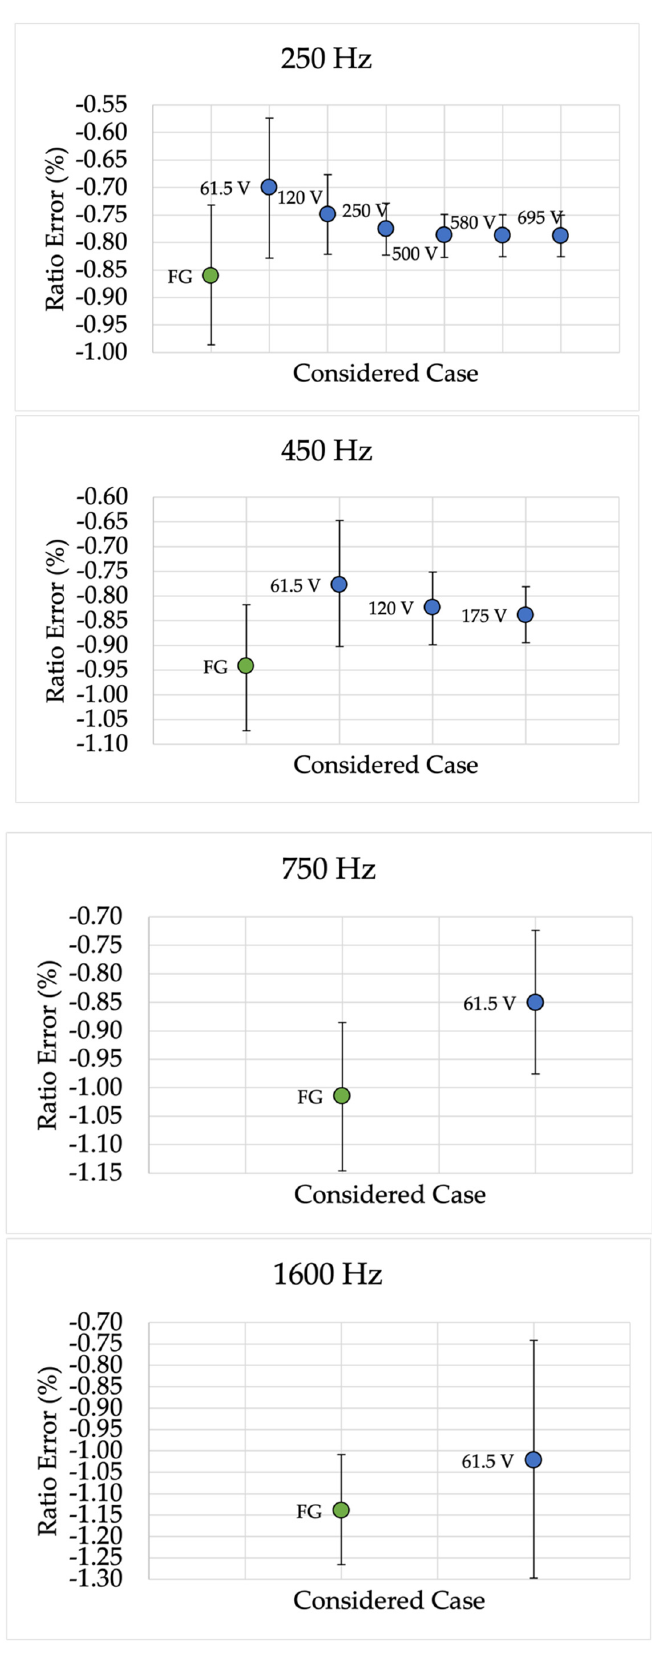
Figure 7. Ratio error 95% confidence intervals for different frequencies and for device P.